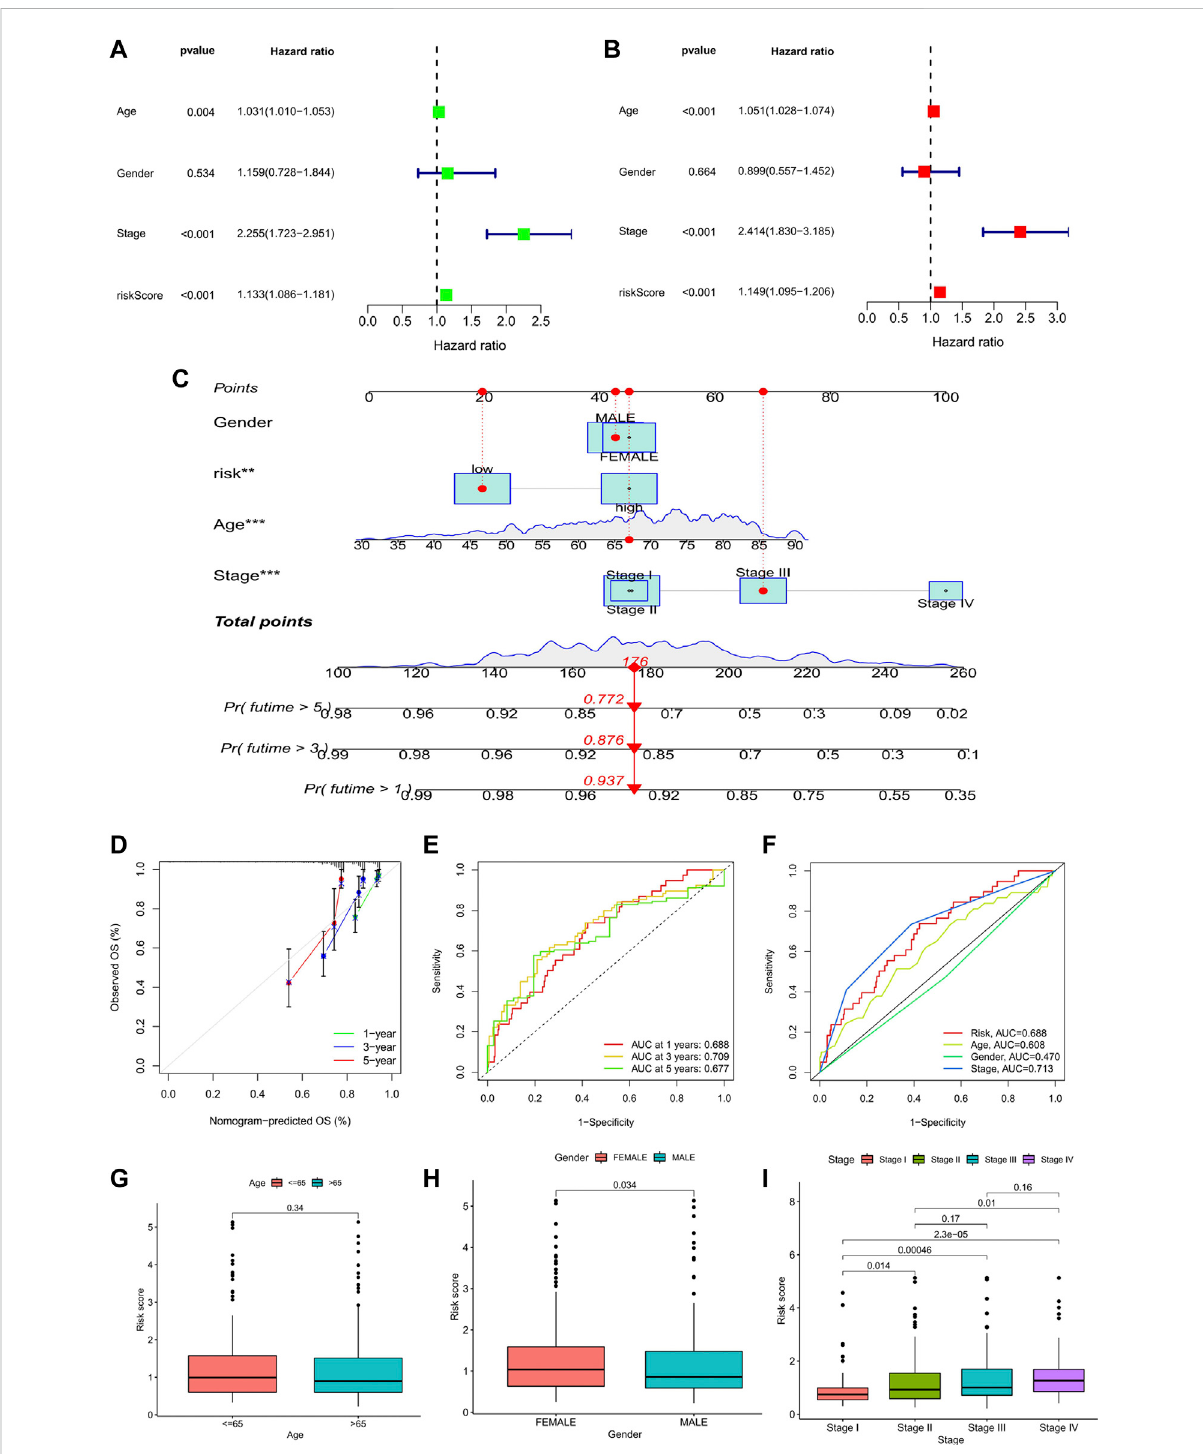
FIGURE 6 Analysis of prognostic factors and construction of nomogram. (A) Univariate analysis identi fi ed prognostic factors, and (B) multivariate analysis identi fi ed prognostic factors as independent predictors. (C) Nomogram used to predict the 1-, 3-, and 5-year survival rate in clinical medicine. (* p < 0.05, ** p < 0.01,*** p < 0.001). (D) Calibration curve to verify the accuracy of nomogram prediction. (E) ROC curves for OS prediction accuracy. (F) ROC curves for risk score and clinical features. (G – I) Analysis of clinical features between high- and low-risk groups in the prognostic model: age; gender; TNM